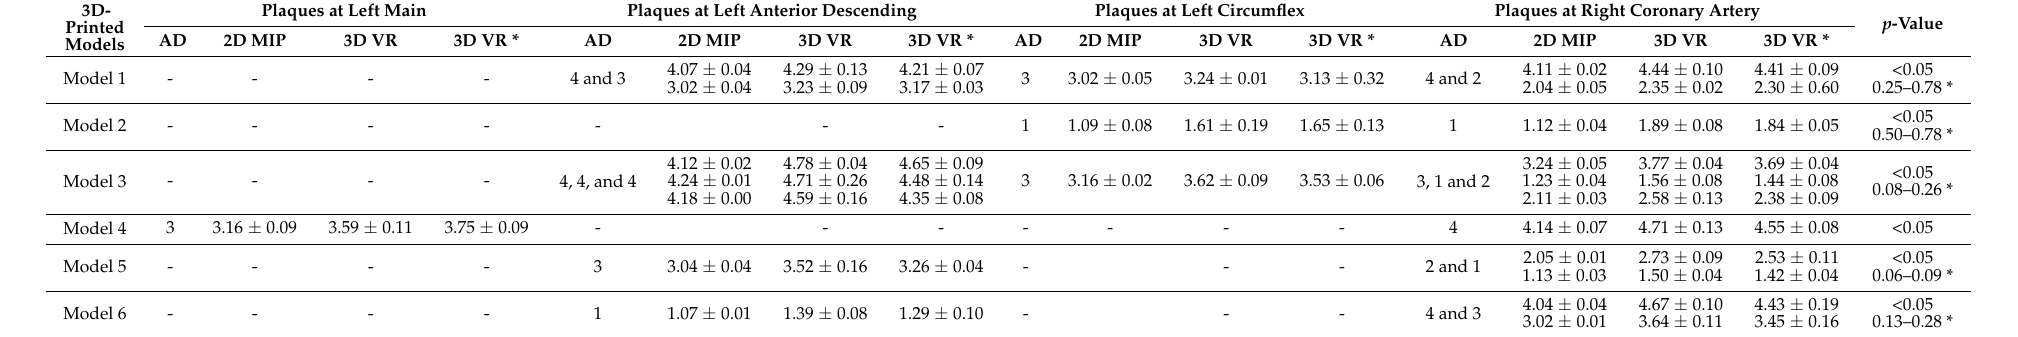
Table 3. Diameter measurements of calcified plaques in 3D-printed coronary models when compared with the actual diameters.